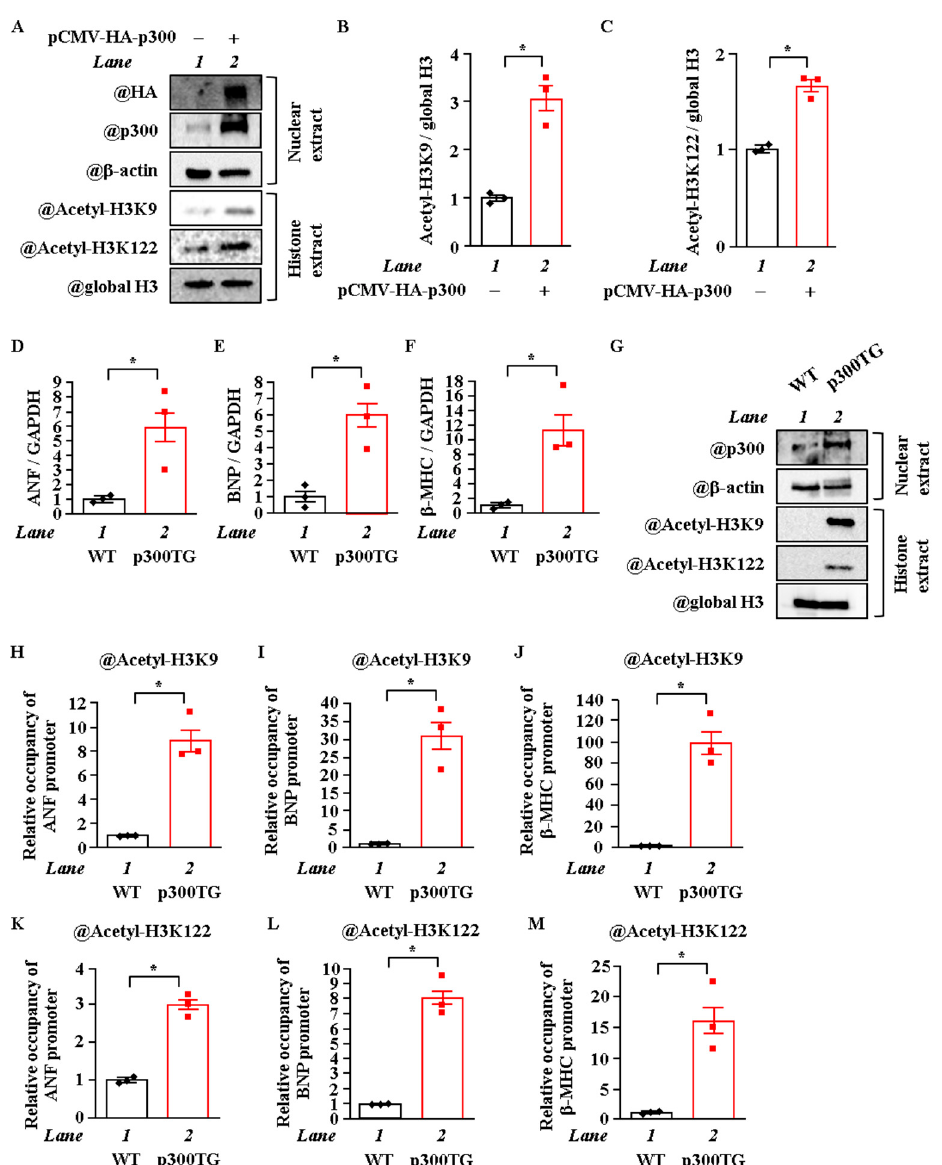
Figure 3 . Cardiac overexpression of p300 increased the acetylation of H3K9 and H3K122 in vitro and in vivo. ( A – C ) Cardiomyocytes were transfected with pCMV-p300 or pcDNA null vector. Nuclear proteins (nuclear extract) and histone fraction (histone extract) were extracted from these cardiomyocytes. ( A ) is a photograph of a representative Western blot, and ( B ) and ( C ) are quantifi- cations of ( A ). ( D – F ) mRNA was extracted from the hearts of p300 TG or WT mice at 26 weeks of age, and the mRNA levels of ANF ( D ), BNP ( E ), and β -MHC ( F ) were measured. ( G ) Nuclear pro- teins and histone fraction were extracted from hearts of TG and WT mice. ( H ~ M ) In vivo ChIP assay was performed using heart lysates from p300 TG and WT mice with anti-acetyl-histone H3K9 antibody ( H ~ J ), anti-acetyl-histone H3K122 antibody ( K ~ M ), or normal rabbit IgG as a nega-